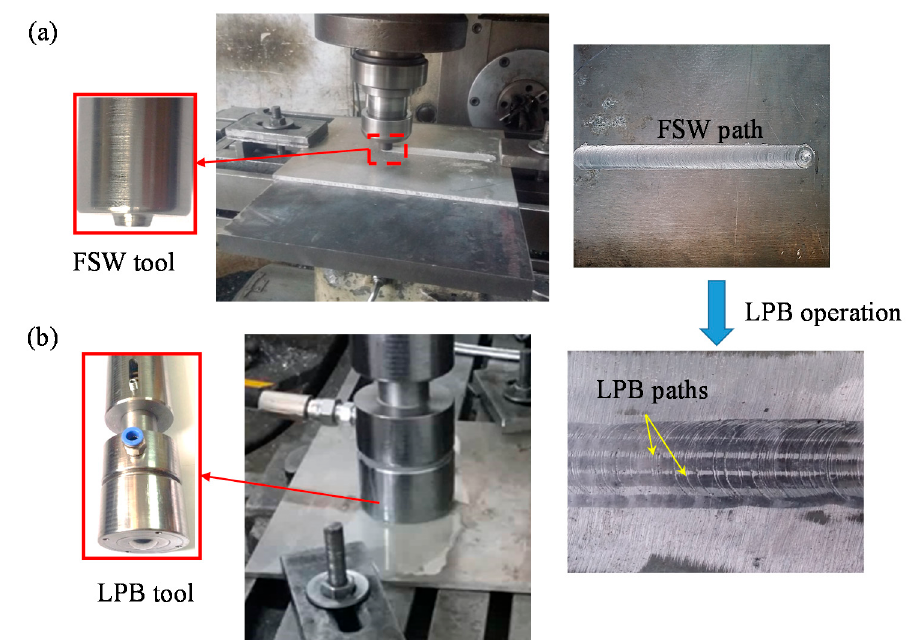
Figure 2. ( a ) The LPB tool and set up; ( b ) burnished paths on the Al 7075-T6 welded joint.